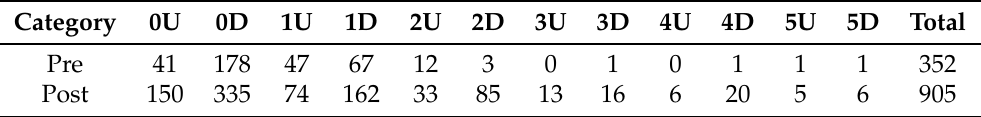
Table 2. Number of whistles by categories according to whether they occurred before or after the